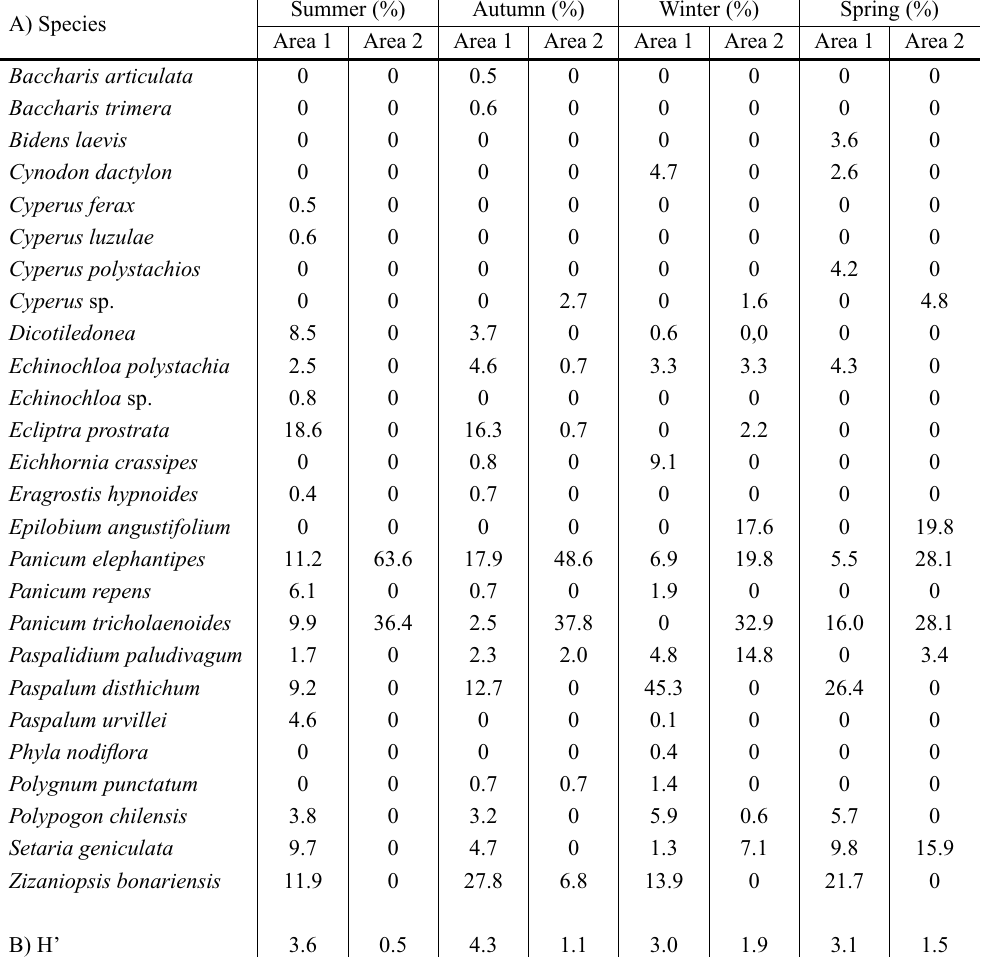
(A) Species of plants identified in coypu’s diet ( Myocastor coypus ) and percentage of contribution from each alimentary item in different seasons of the year. (B) Seasonal diversity of diet (H’ = Shannon’s Diversity Index). Area 1 – Santa Isabel do Sul wetlands; Area 2 – Santa Marta